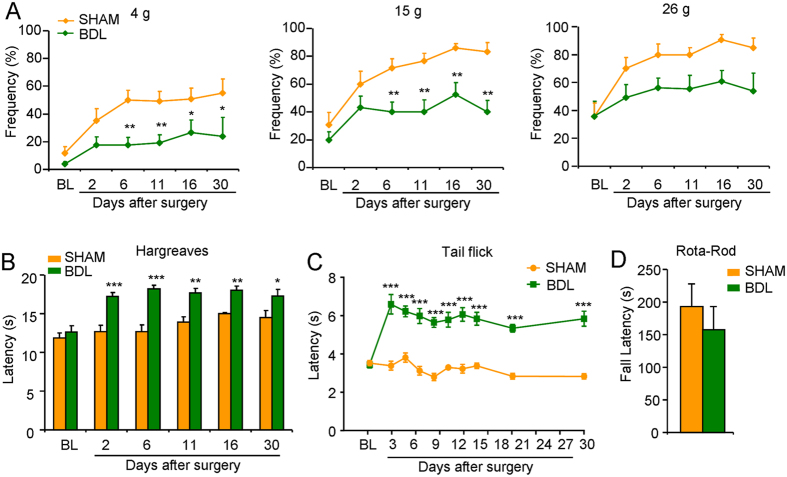
Antinociception responding to heat and mechanical stimuli was induced in BDL rats.(A) We used von Frey filament (4 g, 15 g and 26 g) to evaluate mechanical sensitivity in sham and BDL rats. Compared to sham rats, BDL rats showed reduced mechanical sensitivity 6 to 30 days after BDL surgery (n = 8–12 per group). (B) The Hargreaves test showed that paw withdrawal thermal latency was significantly increased in the BDL rats compared to sham control 6 to 30 days after BDL surgery (n = 6–8 per group). (C) The tail-immersion test showed that latency of tail-flick in response to 52 °C hot water was significantly increased in the BDL rats compared to sham group 3 to 30 days after BDL surgery (n = 8 per group). (D) There was no significant difference for the duration to fall from the rod between sham and BDL rats (n = 8 per group) (*P < 0.05, **P < 0.01, ***P < 0.001 versus sham values and analyzed by Student’s t-test or two-way ANOVA followed by Bonferroni’s test).